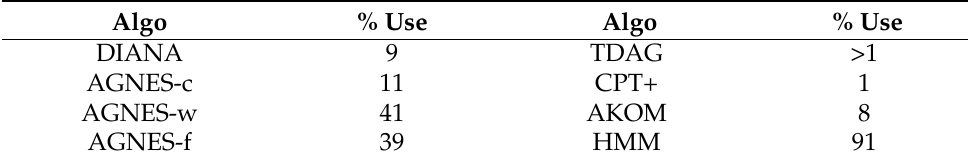
Table 7. Used of each algorithms for an optimal solution.